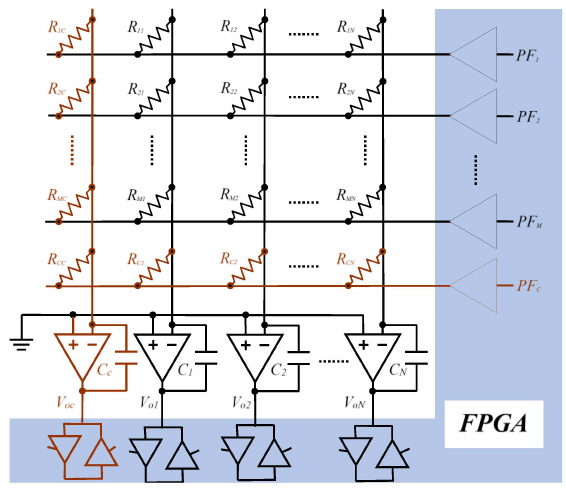
Figure 3. Simplified schematic of the modification proposed for the circuit of Figure 1, in order to consider the buffer resistances and avoid measurement errors in C j and VT j .